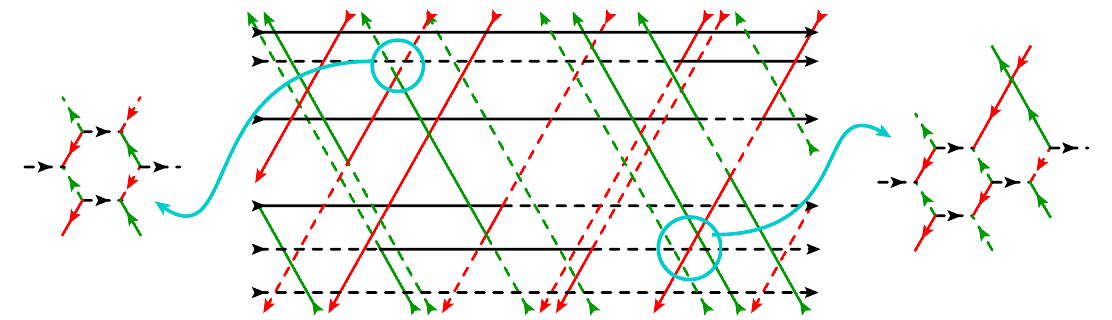
Figure 3 . One of the possible con(cid:12)gurations in terms of e(cid:11)ective vertices of table 1 for the bulk topology represented in (cid:12)gure 2. The diagrams at the two sides of the (cid:12)gure represents the parts of the graph in the light-blue circles in terms of real vertices of (cid:12)gure 1 according with the rules given in table 1. We stress that given a set of e(cid:11)ective vertices, the translation in real vertices is unique. same polygon can appear in the